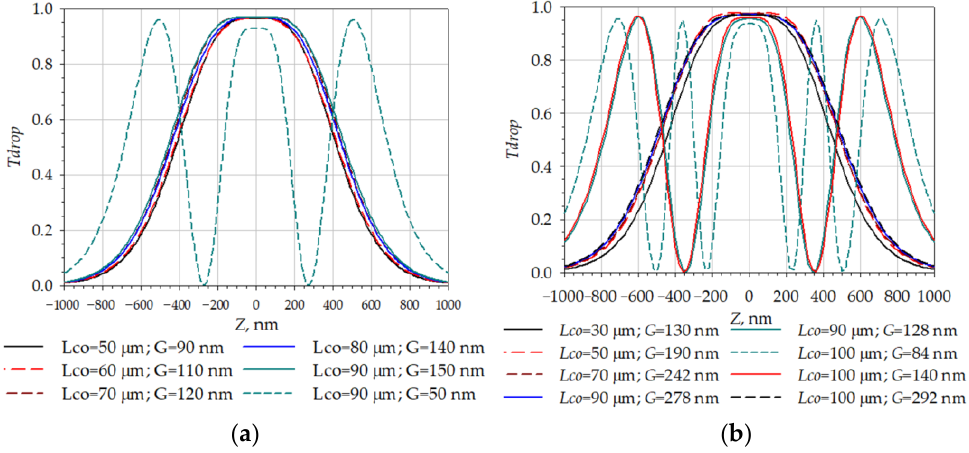
Figure 17. Dependencies of the optical transmission coefficient on the inertial mass linear displace- ment along axis Z for the OMT with single-plane waveguides (Scheme 3). ( a ) Waveguides with di- mensions of 300 × 1000 nm; ( b ) Waveguides with dimensions of 300 × 750 nm .